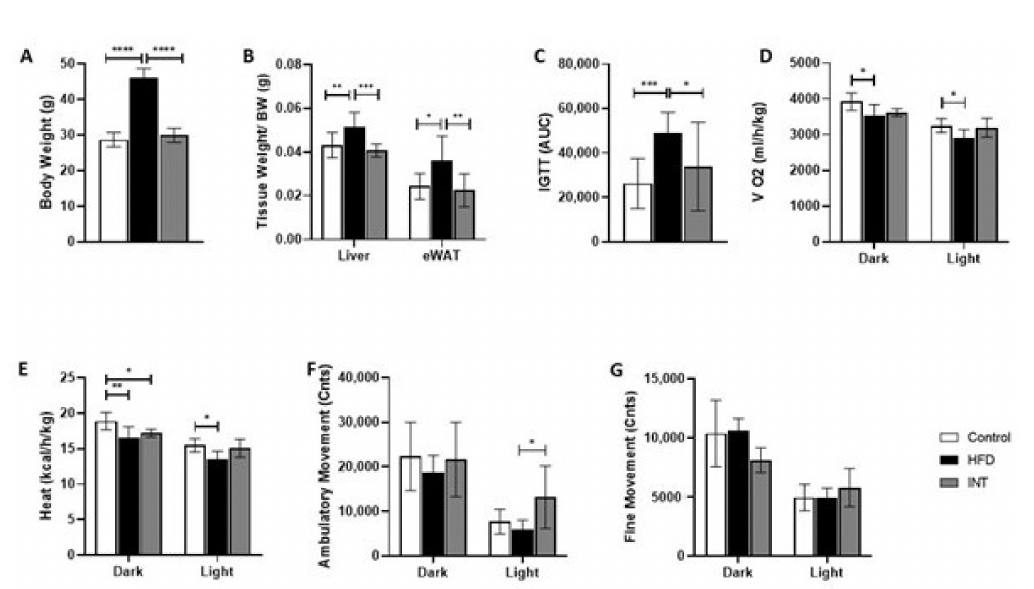
Figure 1. Phenotype overview. ( A ) Body weight (BW) (control (Ctrl) n = 13; high-fat diet (HFD) n = 12; intervention (INT) n = 14). ( B ) Tissue weights of liver and epididymal white adipose tissue (eWAT) normalised to body weight (Ctrl n = 9; HFD n = 11; INT n = 10). ( C ) Glucose homeostasis, intraperitoneal glucose tolerance test (IGTT) after overnight (16 h) fasting represented as area under the curve (AUC) (Ctrl n = 13; HFD n = 13; INT n = 14). ( D ) Oxygen consumption. Average O 2 volume (VO 2 ) measurements normalised by BW during the dark and light phase of the day (Ctrl n = 10; HFD n = 5; INT n = 6). ( E ) Heat production normalised by BW during the dark and light phases (Ctrl n = 10; HFD n = 5; INT n = 6). ( F ) Activity represented by counts of ambulatory movement (Ctrl n = 10; HFD n = 5; INT n = 6). ( G ) Activity represented by counts of fine movement (Ctrl n = 10; HFD n = 5; INT n = 6). Data represented as mean ± SEM, one-way analysis of variance (ANOVA) and post-hoc Tukey’s tests, * p < 0.05, ** p < 0.01, *** p < 0.001, and **** p <